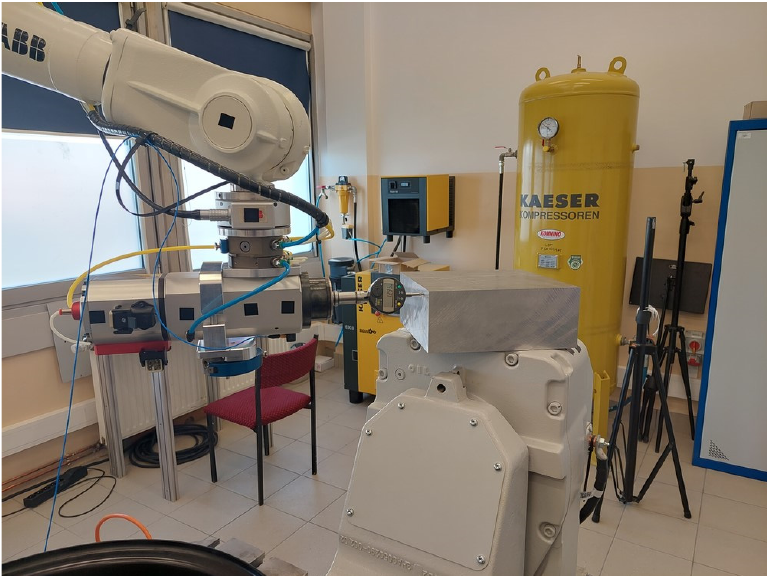
Figure 18. Robotic stand for determining the error in conditions similar to real ones.